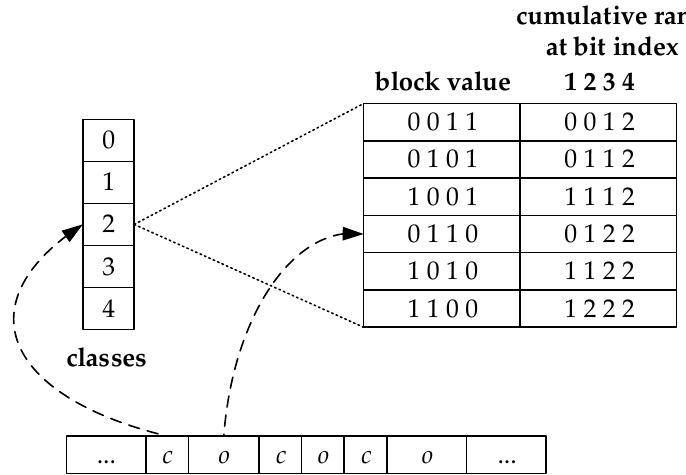
Figure 7. An example of an RRR table, with a lookup for class 𝑐 = 2 and offset 𝑜 = 3 .